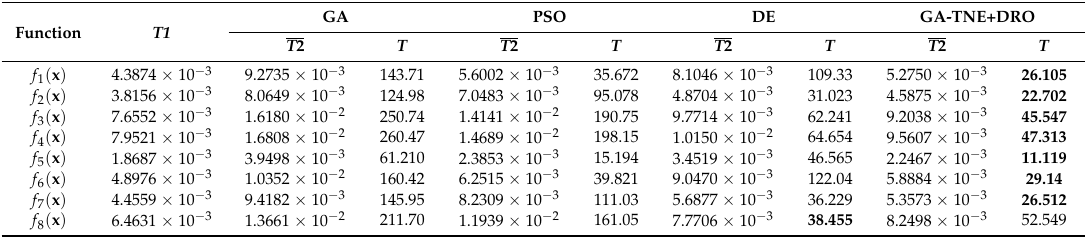
Table 6. Algorithm complexity (the best obtained results are highlighted in bold). Function